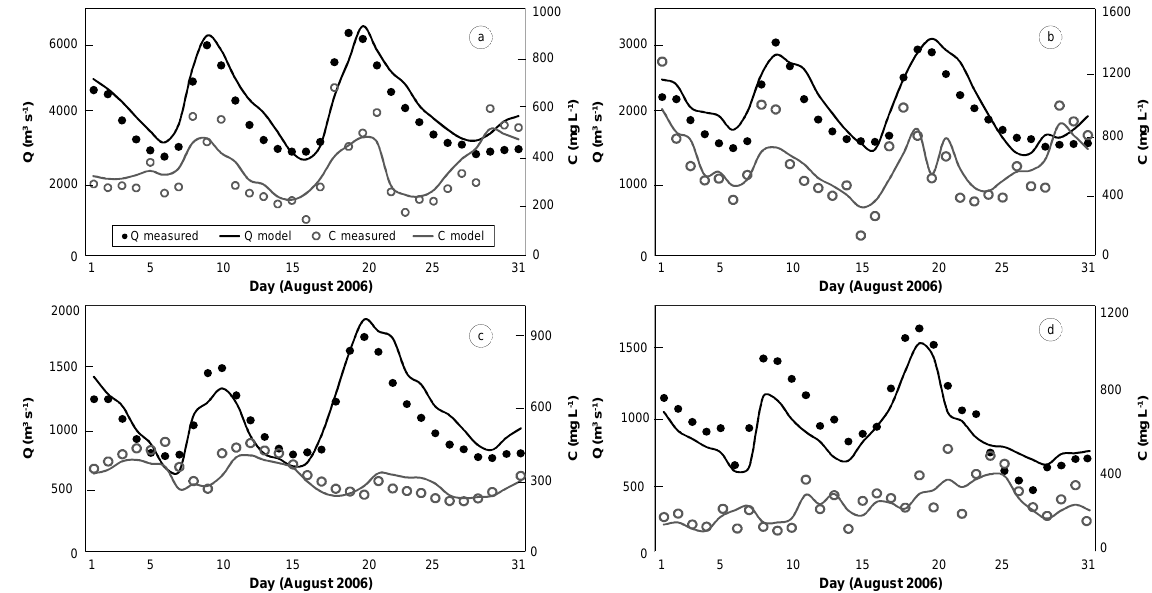
Figure 3. Comparison of modelled and measured water discharge ( Q ) and suspended sediment concentration ( C ) in August 2006 (a – Hanoi; b – Thuong Cat; c – Nam Dinh; d – Cua Cam) after calibration of the model. Table 1. Average water and suspended sediment fluxes obtained from measurements at five gauging stations during the dry season (December–April), the rainy season (June–October), and per year, before (1960–1979) and after (1989–2010) Hoa Binh dam impoundment (see the locations of the stations in Fig.